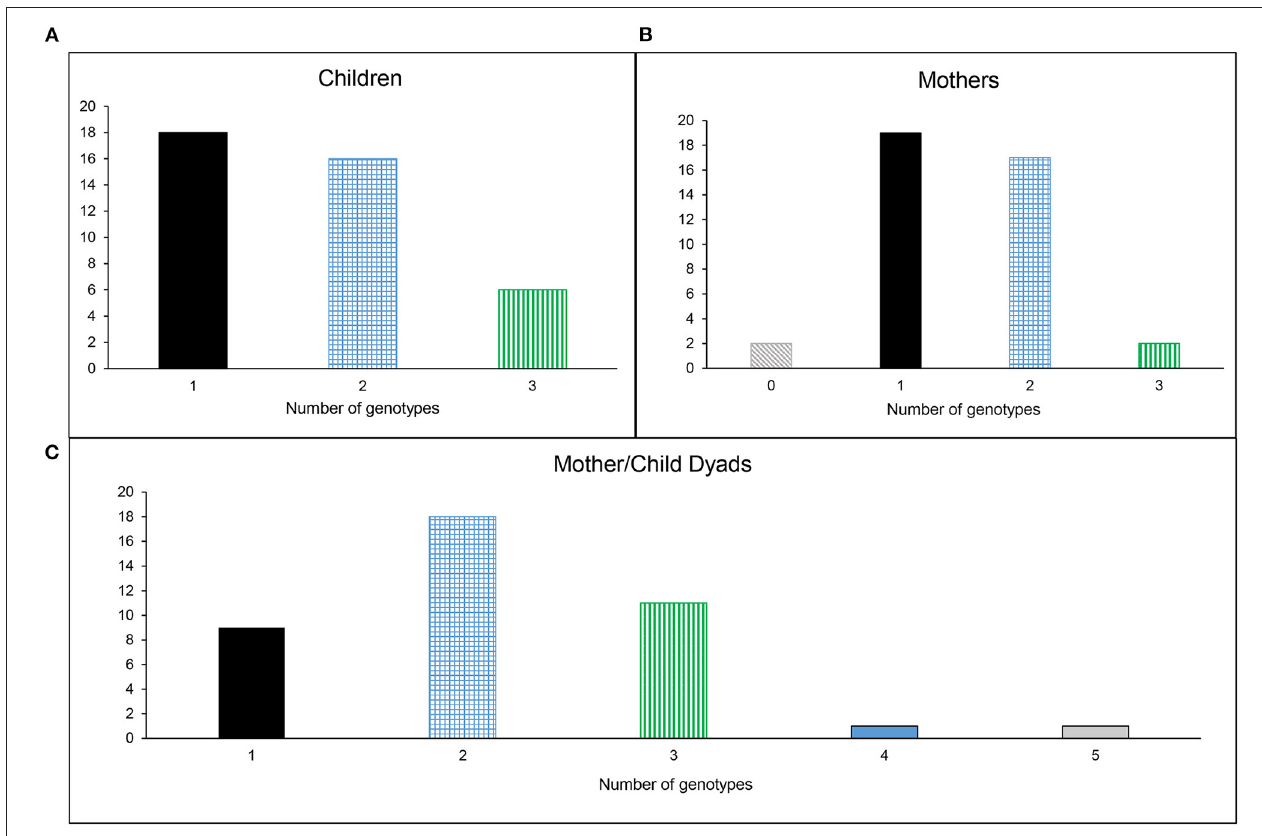
FIGURE 1 | Genotypic diversity of S. sobrinus in (A) Children, (B) Mothers, and (C) Mother/Child Dyads.